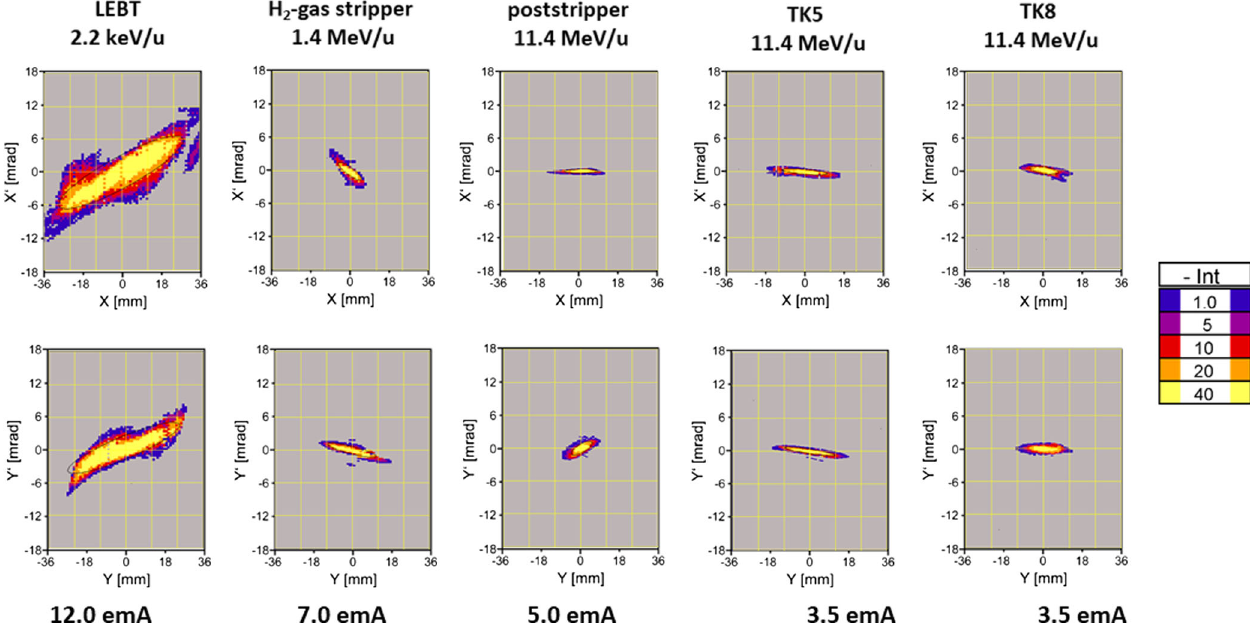
FIG. 8. High-intensity uranium-beam emittance and current measurement along